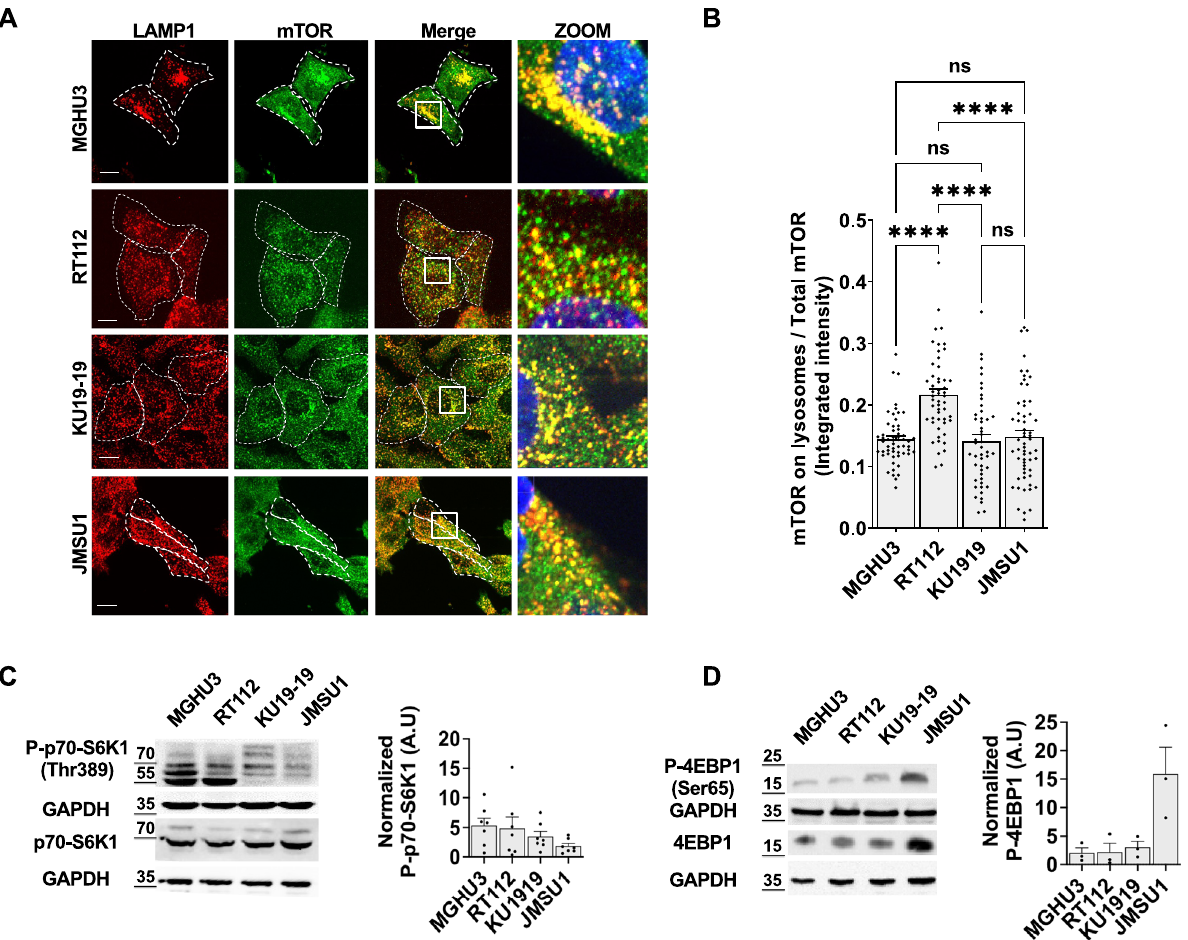
Fig. 2 Dispersed lysosomes reveal alterations in mTORC1 signaling. A Immuno fl uorescence staining of the lysosomal-associated membrane protein 1 (LAMP1, CD107a) and mTOR in MGHU3, RT112, KU19-19 and JMSU1. The zoom shows the merged image for both proteins in the white box. Scale